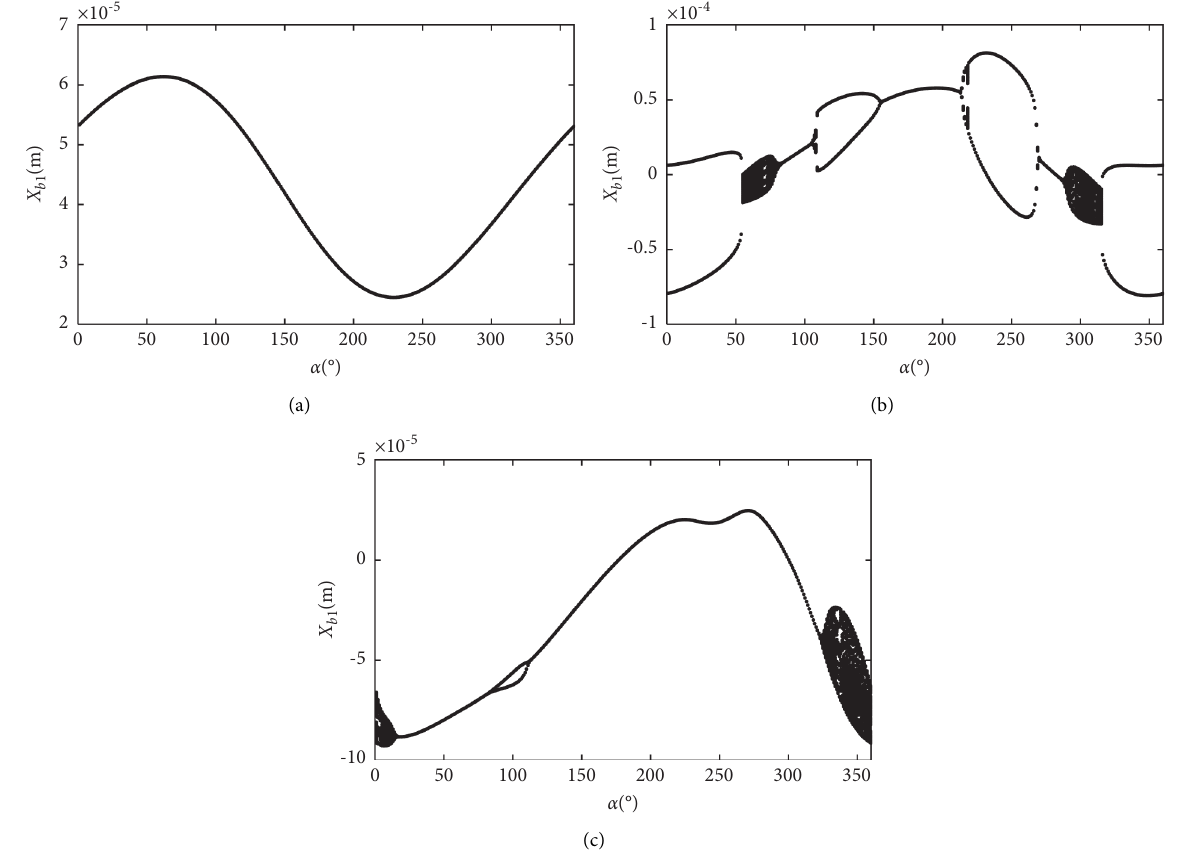
Figure 11: Bifurcation diagram of blade fault location α : (a) 2000rpm; (b) 5000rpm; (c) 8000rpm.